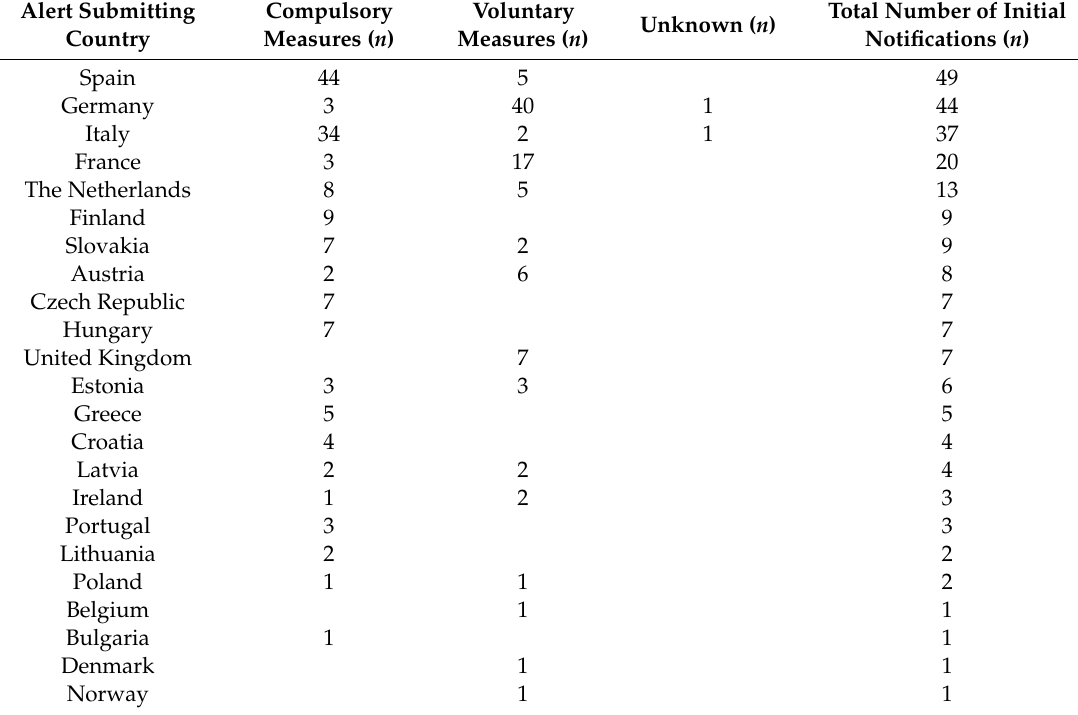
Table 3. Number of compulsory and voluntary measures per reporting country